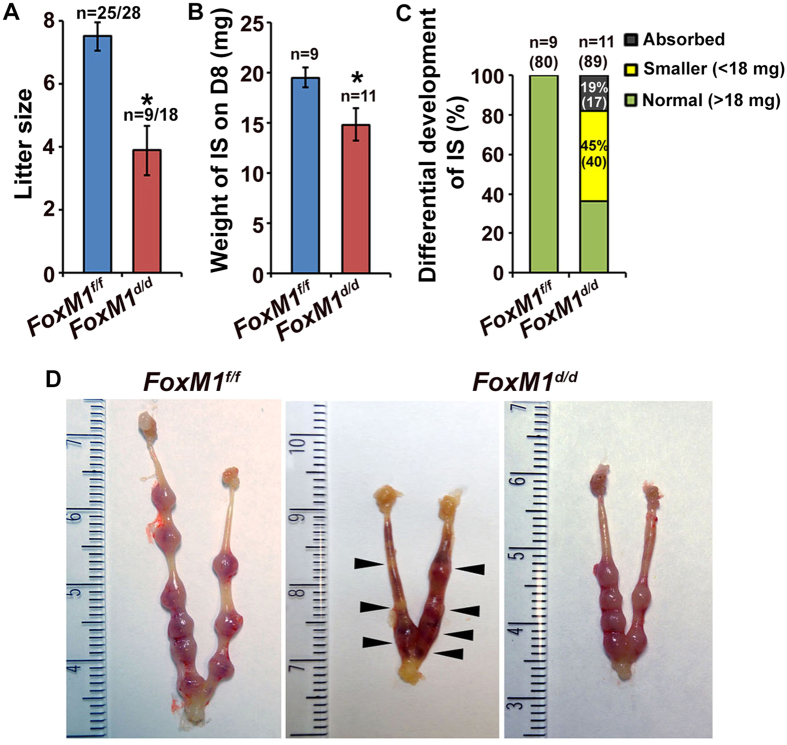
Uterine deletion of FoxM1 results in female subfertility with loss of embryo implantation during decidualization.(A) Pregnancy outcome in null (FoxM1d/d) and control (FoxM1f/f) littermates after mating with fertile males. n, indicates number of females with pups out of total plug-positive females for each genotype. Results shown as Mean ± SEM. *Significantly different (p < 0.05). (B) Weight of IS on D8 for null and control littermates. n, indicates number of females with IS for each genotype. Results shown as Mean ± SEM. (C) Developmental competence of IS between null and control on D8. n, indicates number of pregnant females, with a total number of IS (in parentheses) for each group. The percent with total number of IS for each category (absorbed, smaller, and normal) also indicated by color codes. (D) Uterine IS morphology for FoxM1d/d and FoxM1f/f mice is shown on D8. Arrowheads point to resorption sites.